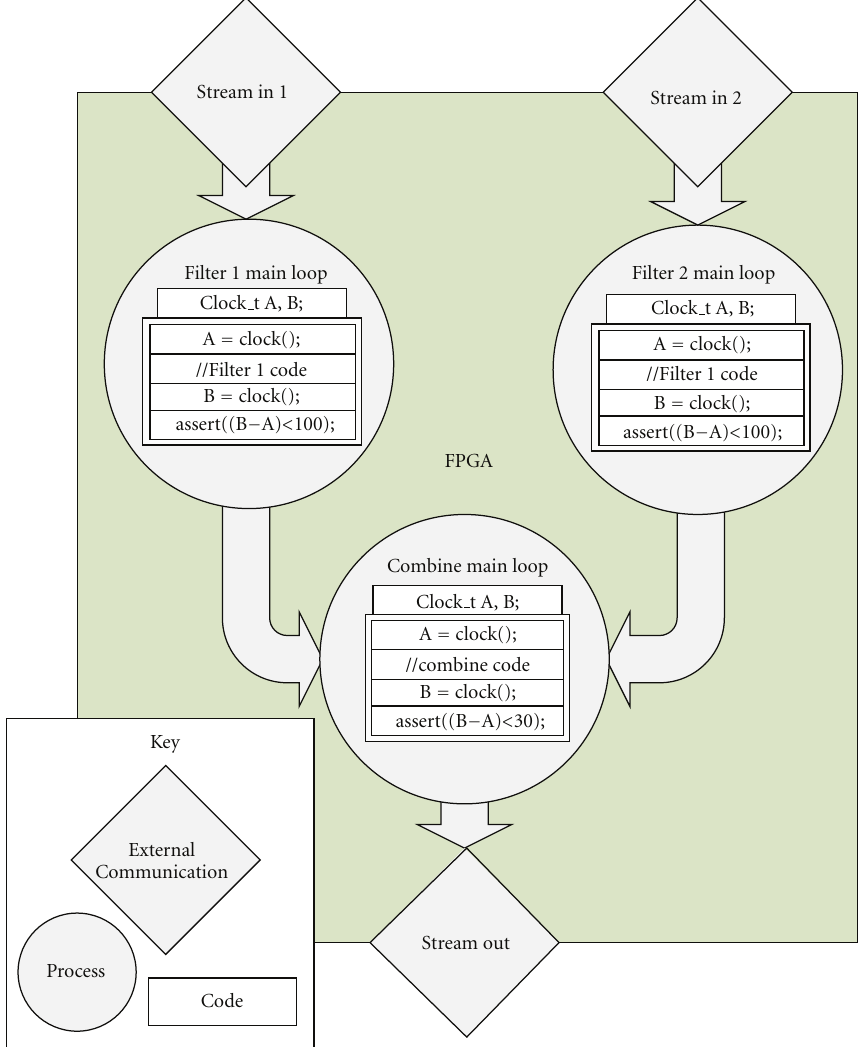
Figure 5: Using timing-analysis assertions with a filter application.